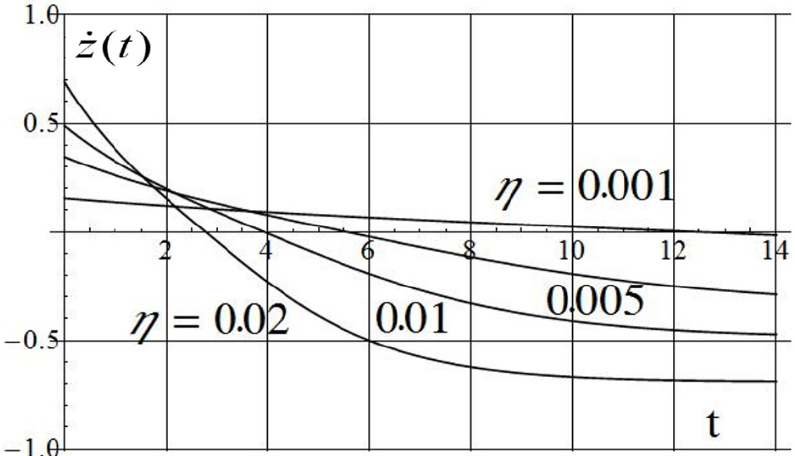
Figure 7. Submersion of the cylinder from the start of deceleration until complete stop considering the subsequent ascension for an instantaneous change in buoyancy ( t 0 = 0 ) from − η to η .